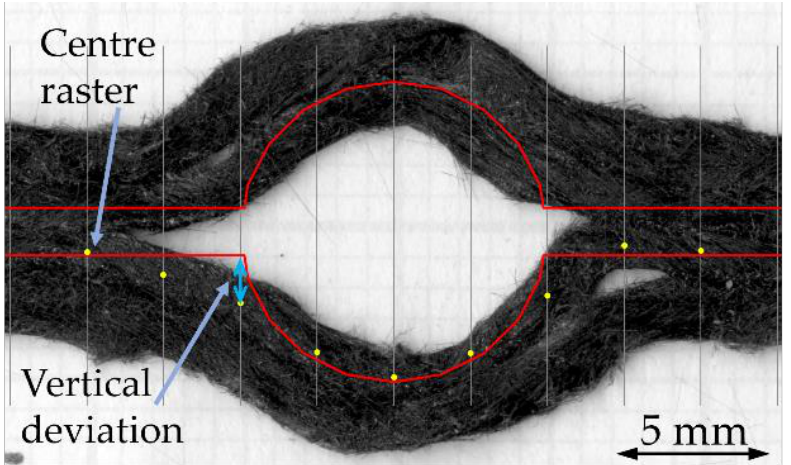
Figure 14. An example of the deviation calculation of the 10 mm compensated curvilinear part showing the calculated (marked) points and the measured vertical deviation. Table 2. RMS of vertical deviation measuring from the desired path and the centre of the deposited raster.